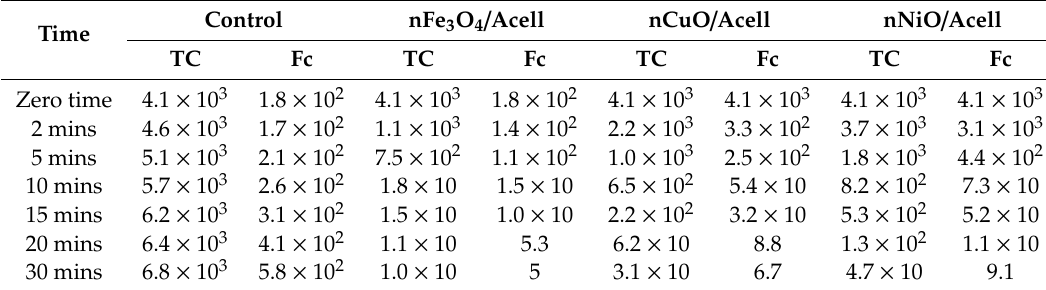
Table 4. Reduction in total and fecal coliforms of crude household wastewater e ffl uent using nMO / Acell nanocomposites at di ff erent contact